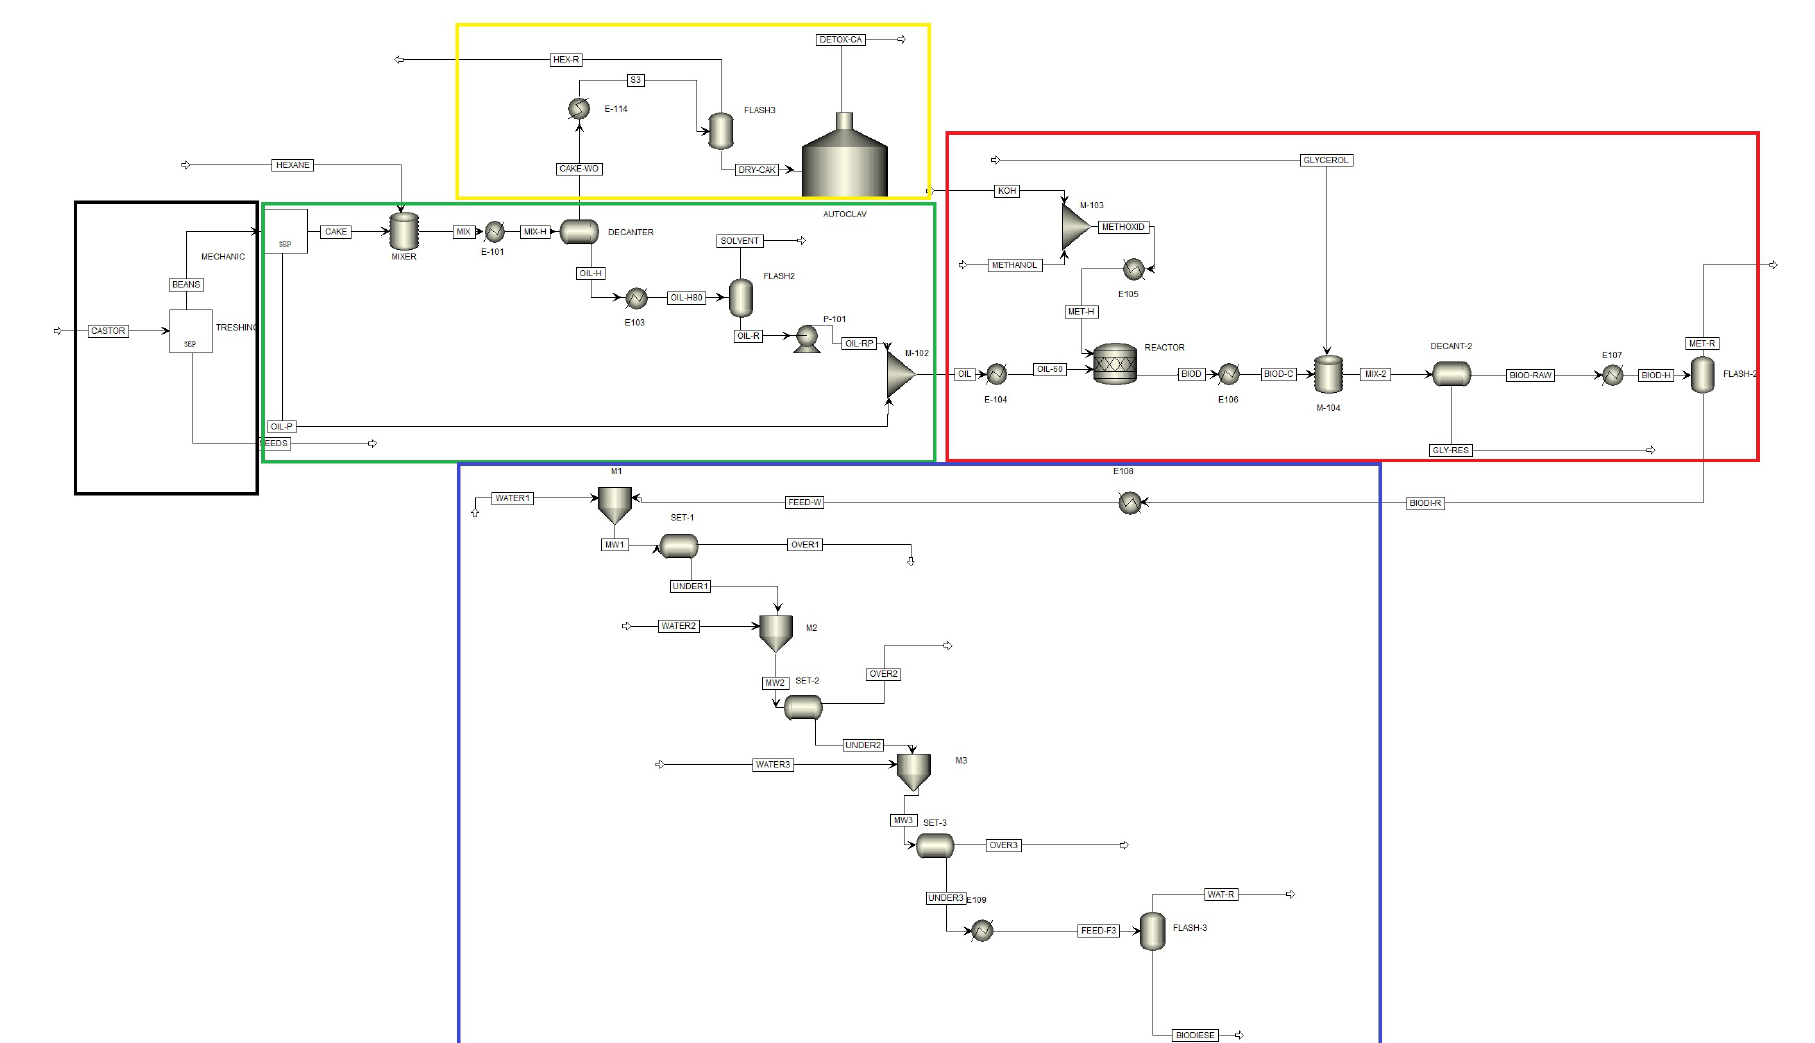
Figure 1. Aspen Plus simulation flowsheet. Castor seed separation (Black), oil separation (Green), biodiesel production (Red), biodiesel purification (Blue), and detoxification